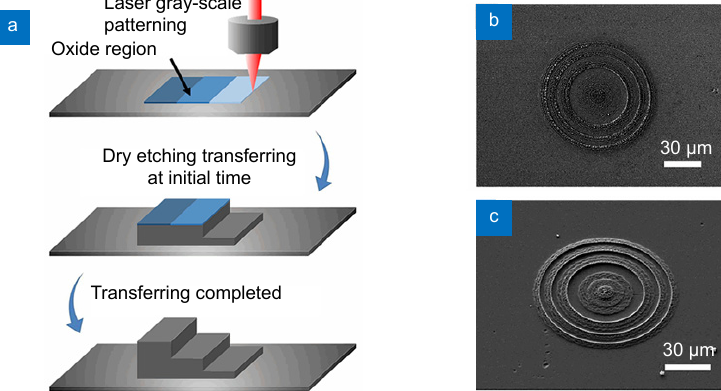
Fig. 10 | Dry-etching assisted femtosecond laser gray-scale modification. (a) Diagram of the fabrication process. (b) SEM of 2D Fresnel zone plate pattern fabricated by femtosecond laser modification. (c) SEM of 3D well-defined Fresnel zone plate fabricated by transferring of 2D pattern with subsequent dry etching. Figure reproduced from (a–c) ref. 104 , AIP